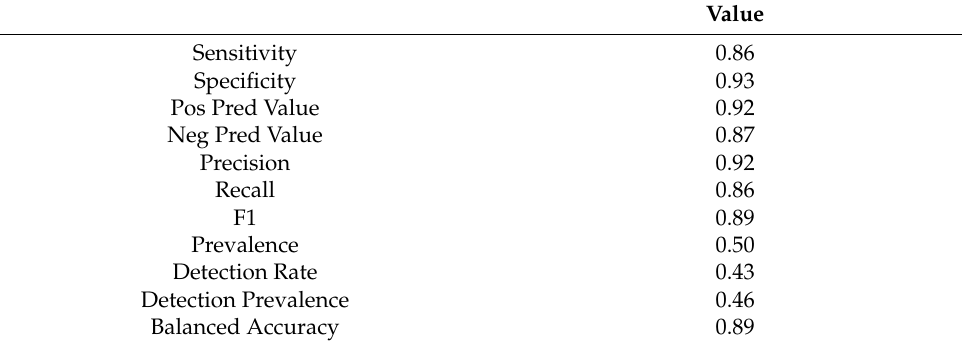
Table 6. Random forest: metrics